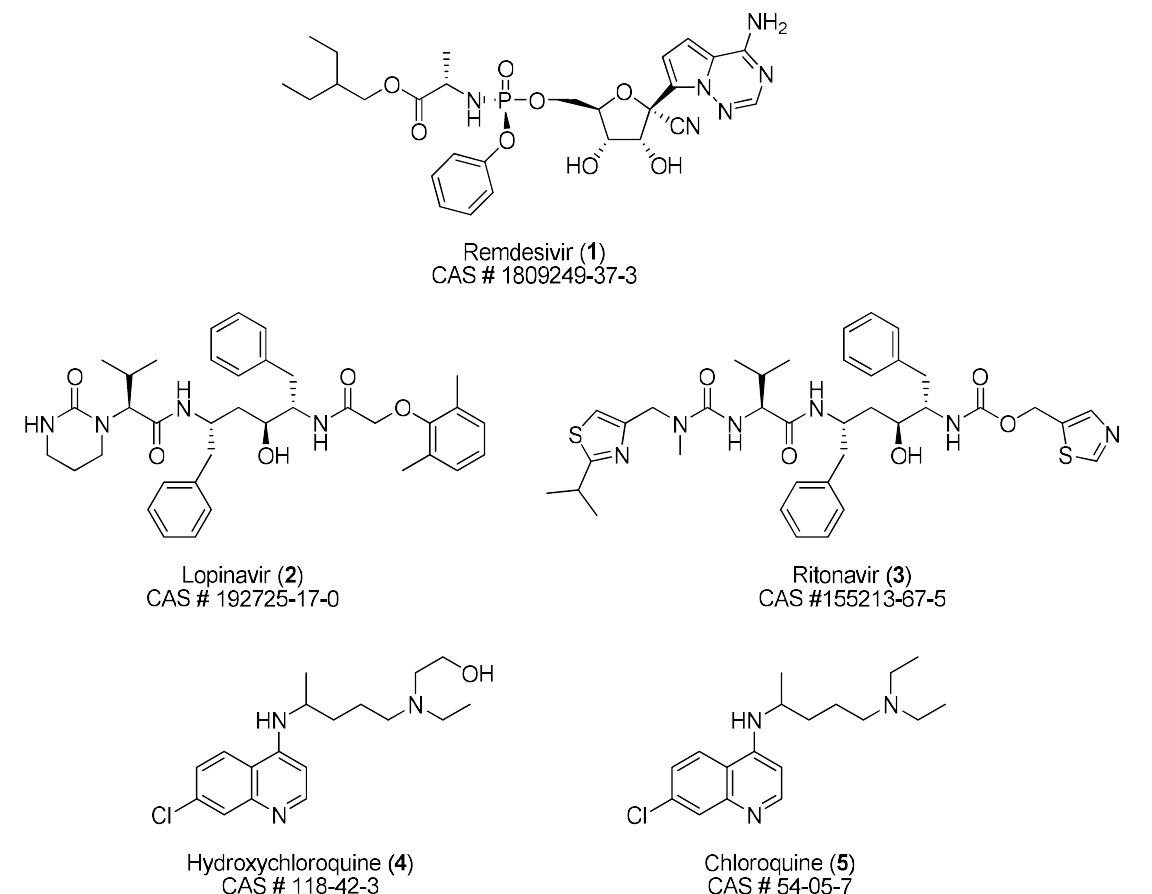
Figure 1. Structure of remdesivir ( 1 ), lopinavir ( 2 ), ritonavir ( 3 ), hydroxychloroquine ( 4 ), and chloroquine ( 5